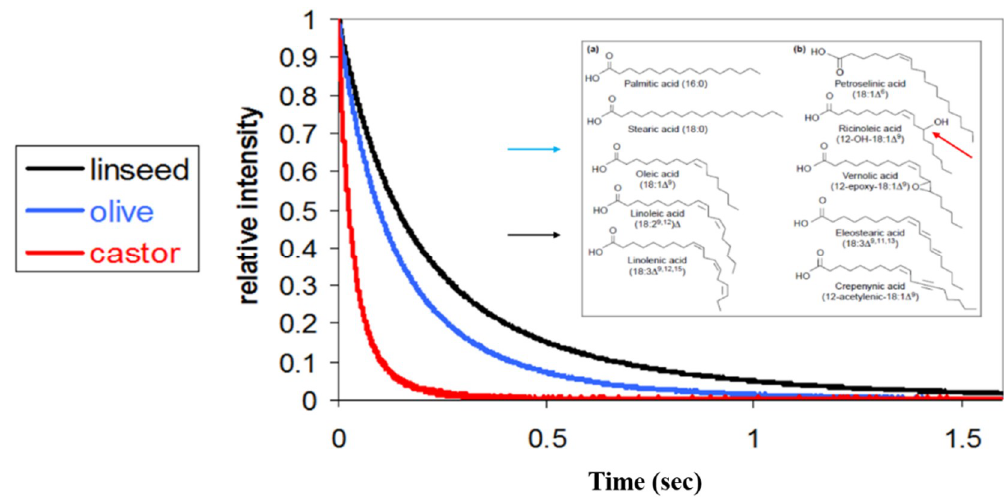
Figure 1. Effect of dominating oil’s fatty acids on 1 H LF NMR relaxation curve.